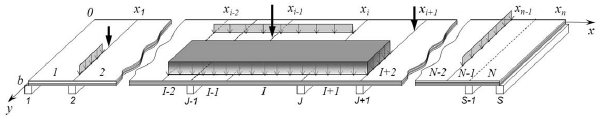
Figure 1: Stiffened plate with strip and edge loadings (Note: The beams are concentric and the lower half of the beams are shown for